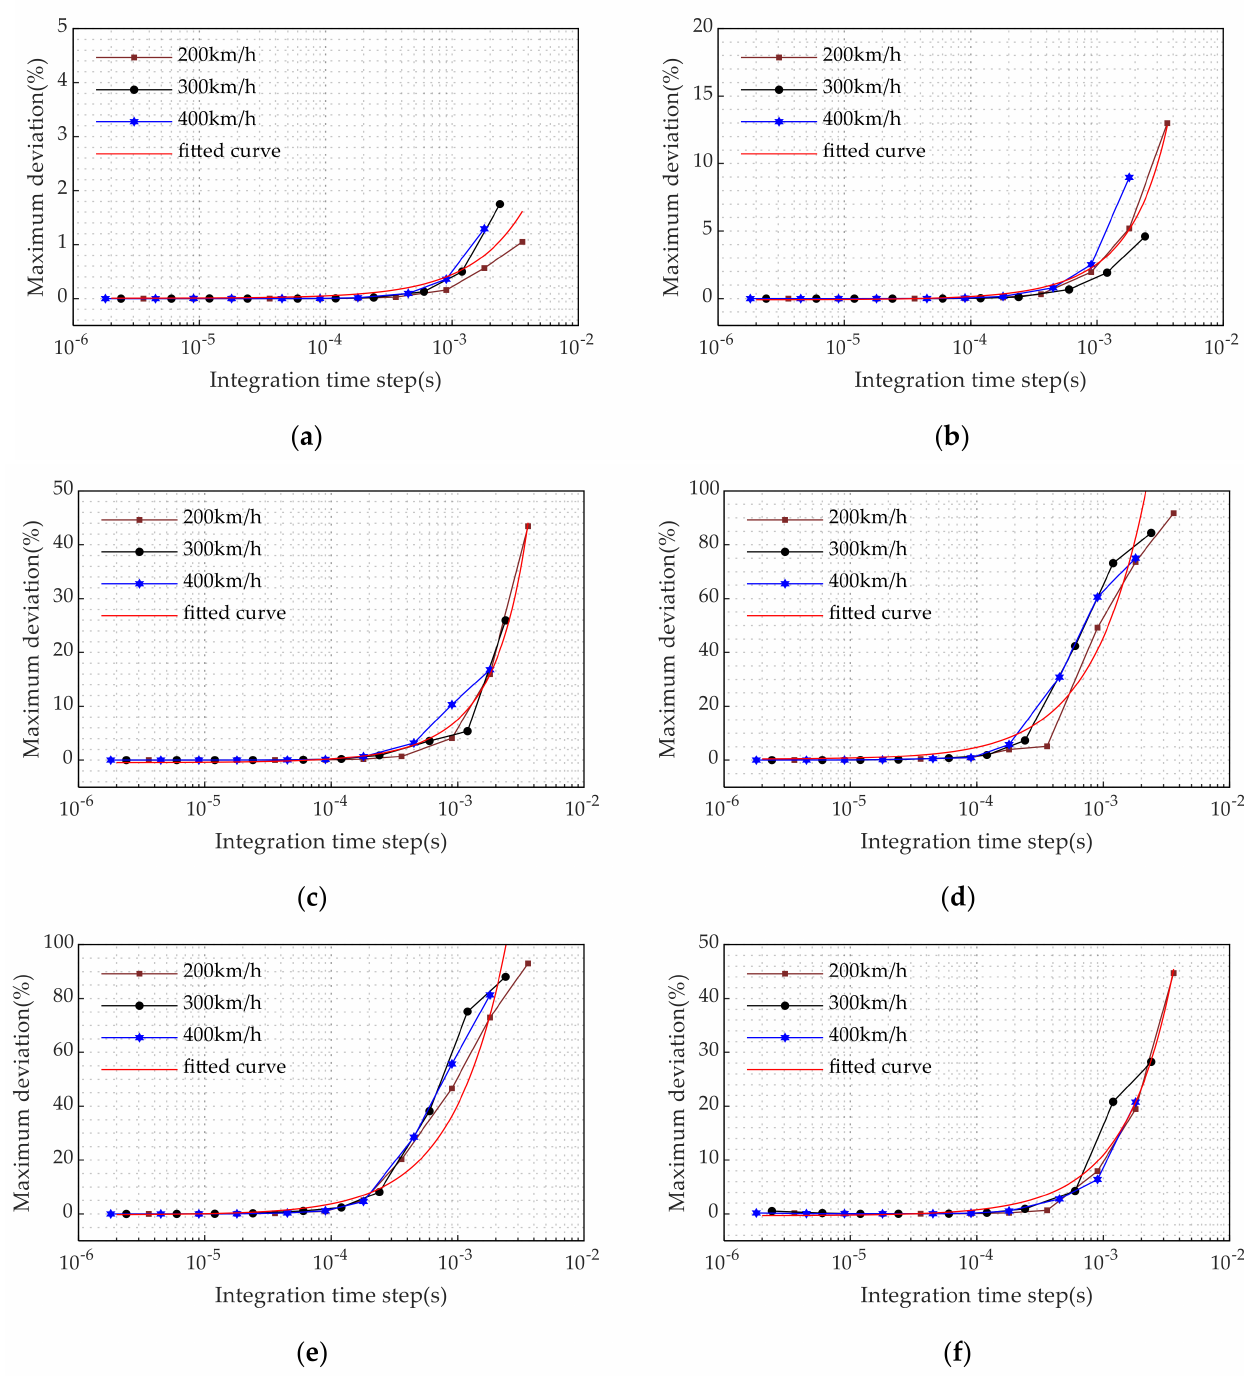
Figure 9. The effect of the integration time step on maximum vertical acceleration of the: ( a ) car body; ( b ) bogie; ( c ) wheel-sets; ( d ) rail; ( e ) track slab; ( f ) bridge at different